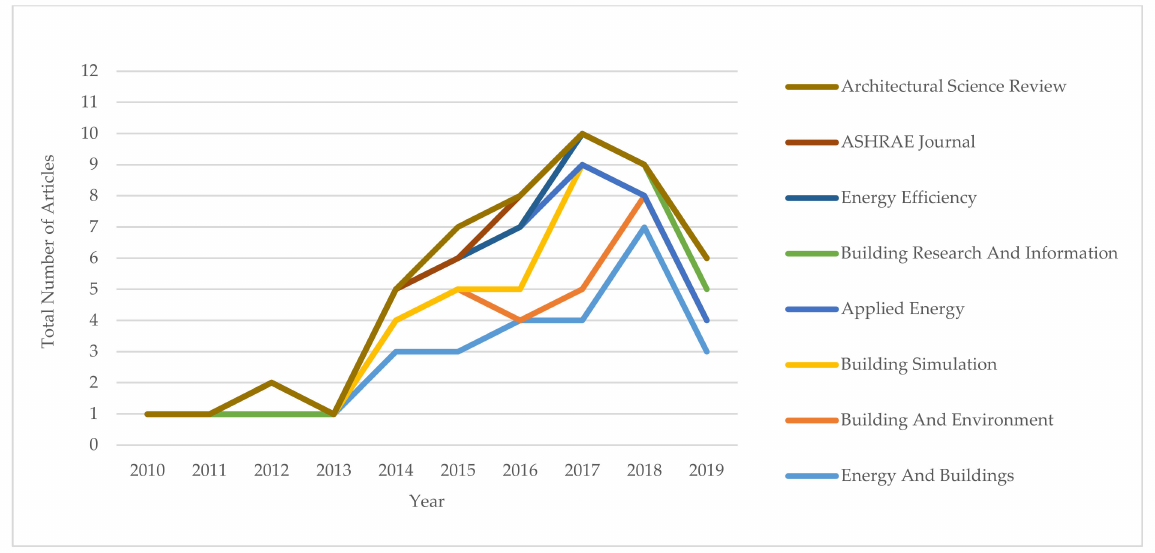
Figure 5. The trend in keywords “Occupant Behavior”, “Modeling”, “Building”, and “Energy